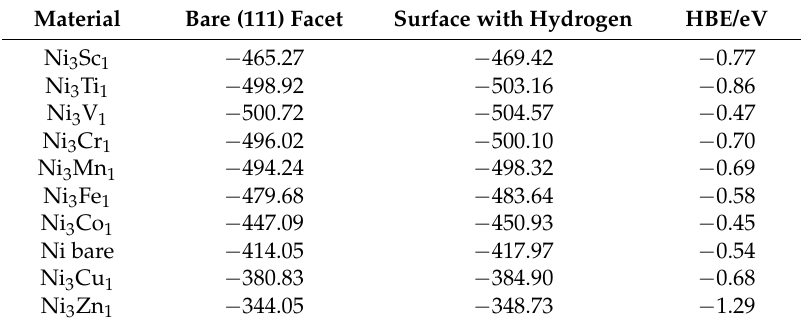
Table A1. Ground state energies of bare metal/alloy and one with hydrogen at (111) facet (1/16 ML) supercell 2 × 2 × 1 and calculated HBE (all energies are in